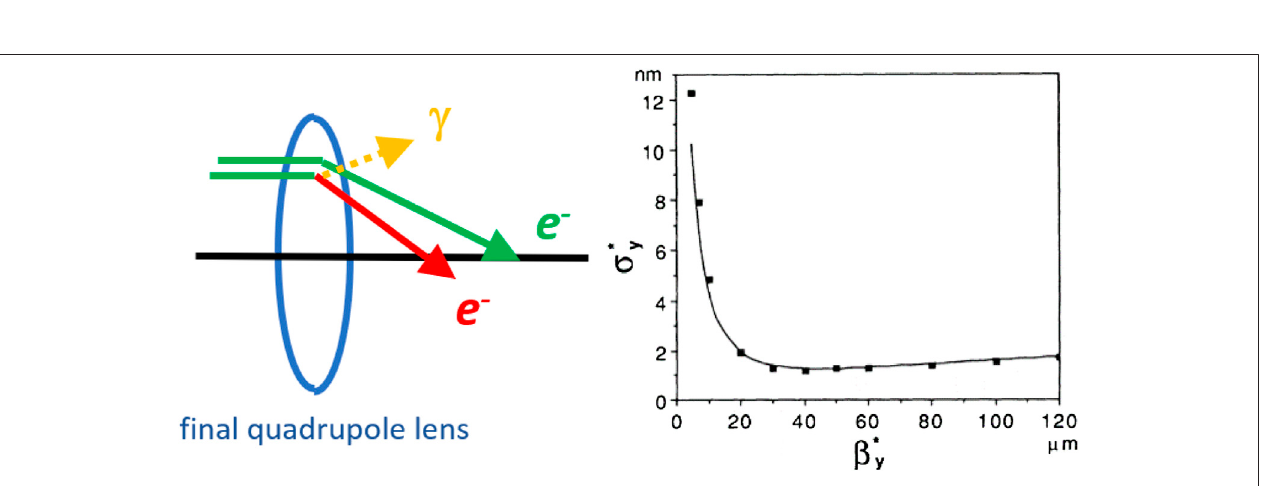
FIGURE2| IllustrationoftheOideeffect,wherephotonemissioninthe fi nalquadrupolelensresultsinaminimumpossiblespotsizeforanoptimizedvalueof β p y [10], and an example of vertical rms beam size versus β p y from Ref. [6].